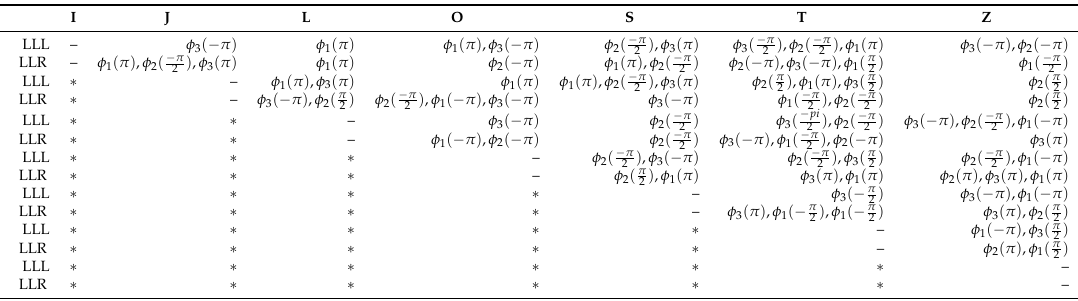
Table 2. Kinematic transformation table for the seven forms, i.e., {I, J, L, O, S, T, Z} from one to another for hTetro-LLL and hTetro-LLR. Note that ∗ , i.e., the elements in lower triangular part of the table are negative of the upper triangular elements. For example in hTetro-LLL, {I to J} has φ 2 ( − π ) then {J to I} is φ 2 ( π )